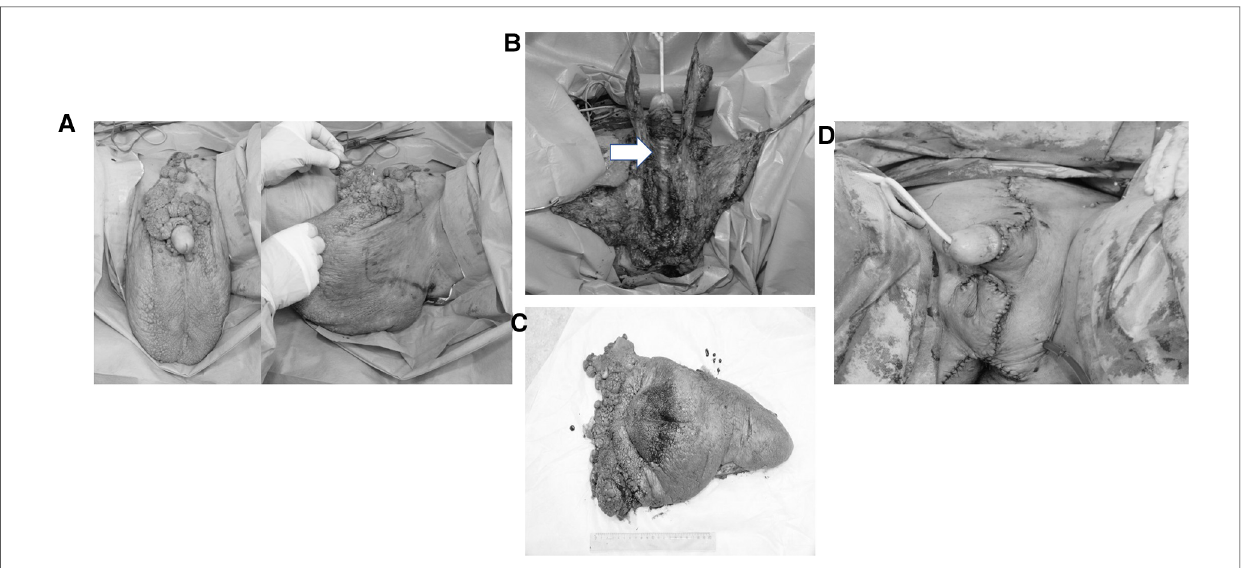
FIGURE 3 Dynamics of tumor resection over a course of surgery. Intraoperative photos were taken to select the resection line ( A ), to demonstrate the excess of soft tissue ( B ), removed soft tissue fragment ( C ) and the outcome of resection ( D ). Naked structures of the penis and dissected testicles are selected by